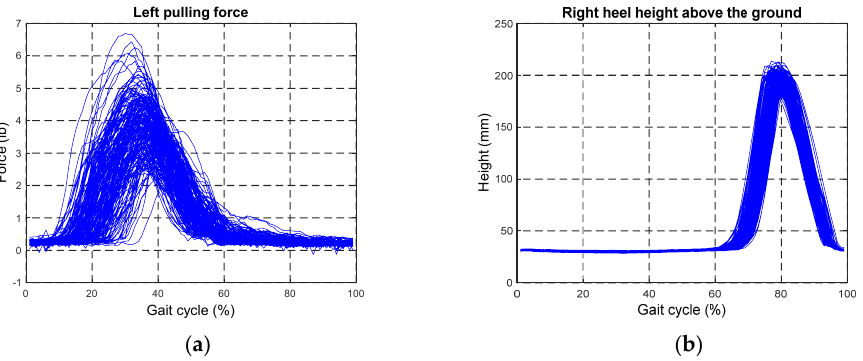
Figure A1. Analyses of the intervention patterns. ( a ) Applied force on the left ASIS; ( b ) heights of the right heel.